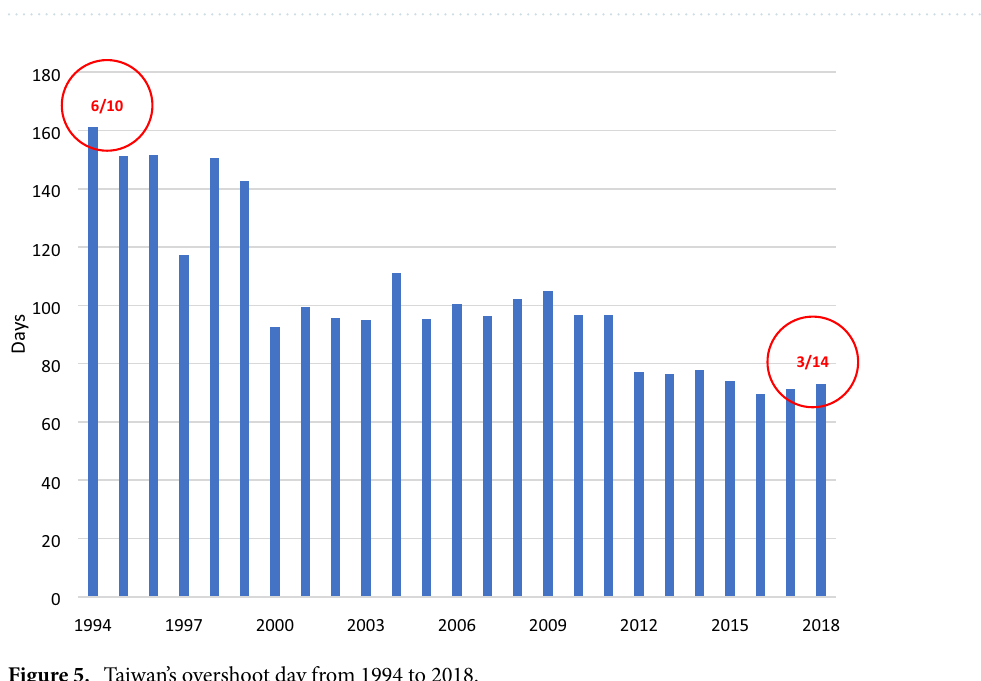
Figure 4. Earth overshoot day from 1970 to 2020. Source : Earth overshoot day (2020).